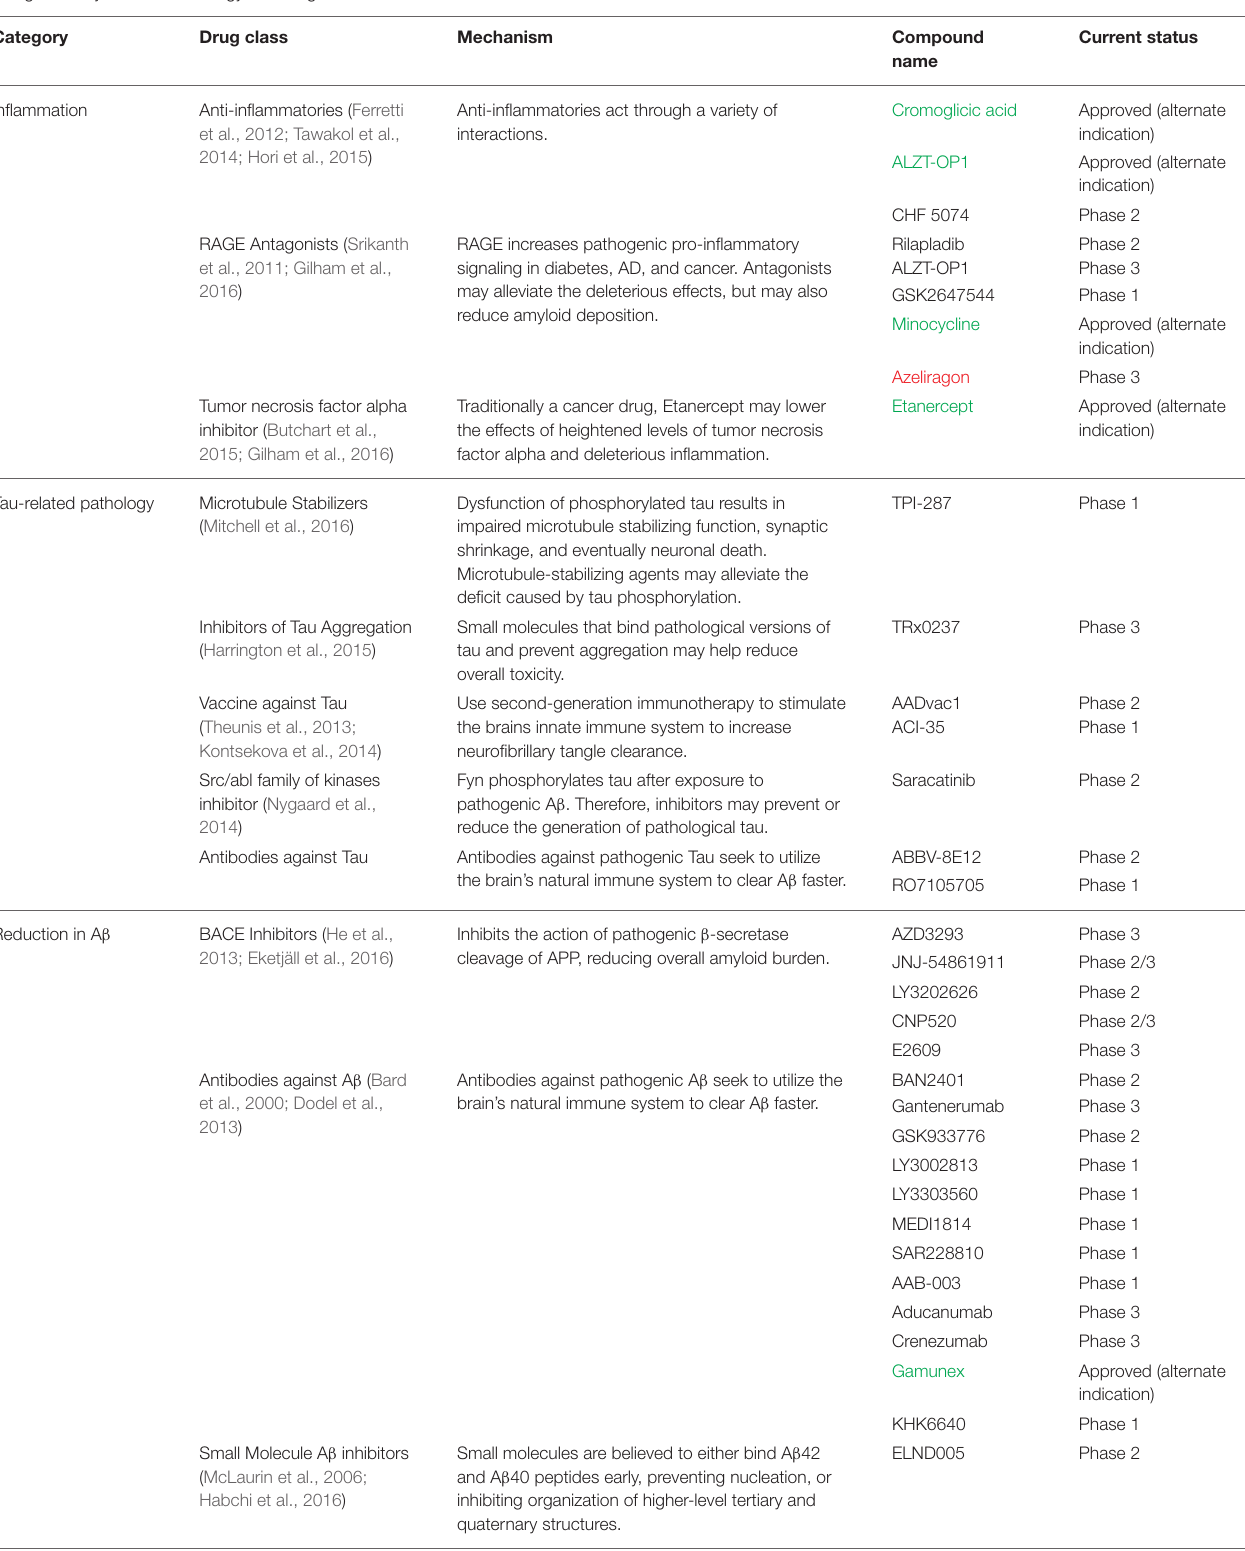
TABLE 1 | A comprehensive list of all of the drugs in clinical development that aim to reduce either A β pathology, tau pathology, or inflammation within the past five years categorized by treatment strategy and drug class.